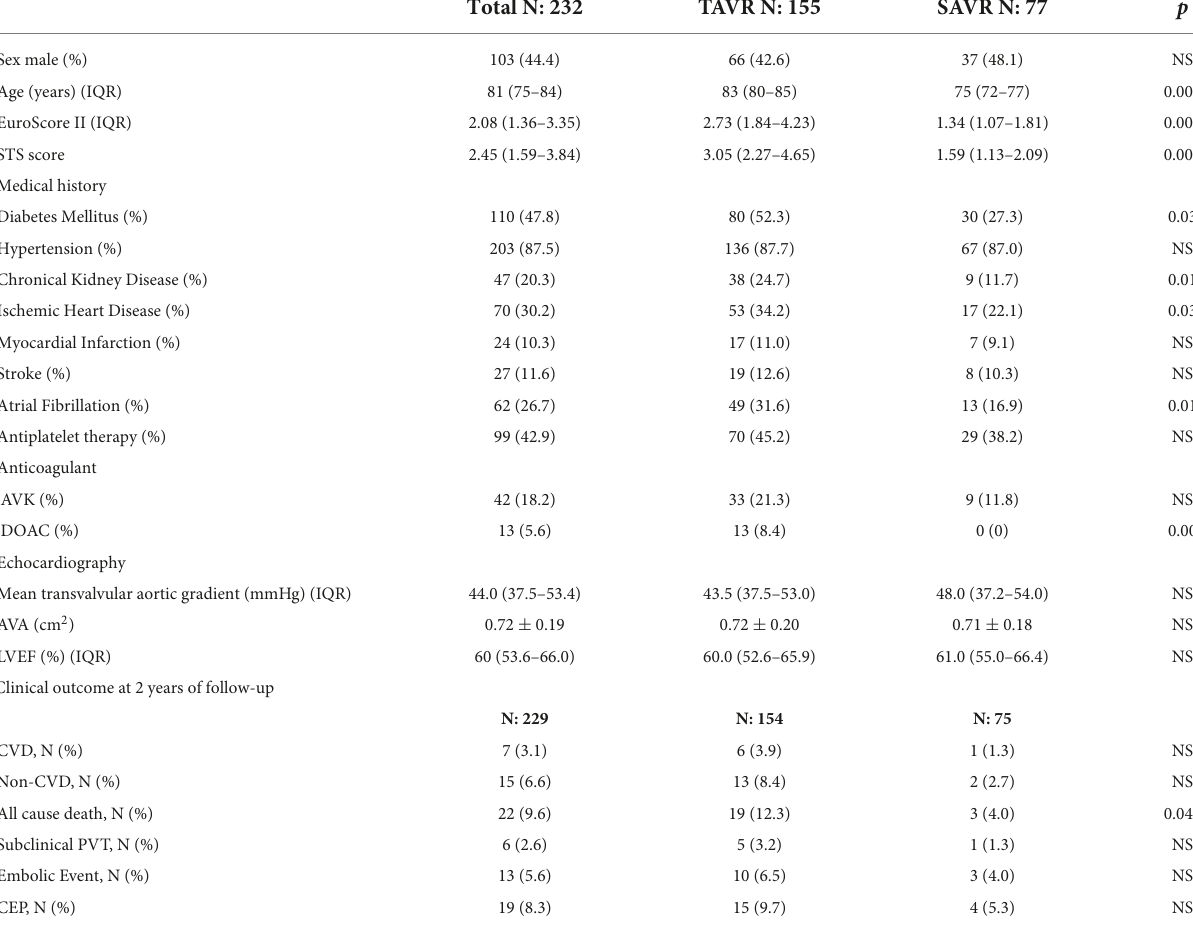
TABLE 1 Demographic, clinical characteristics, and clinical outcomes of patients underwent TAVR or SAVR. Total N: 232